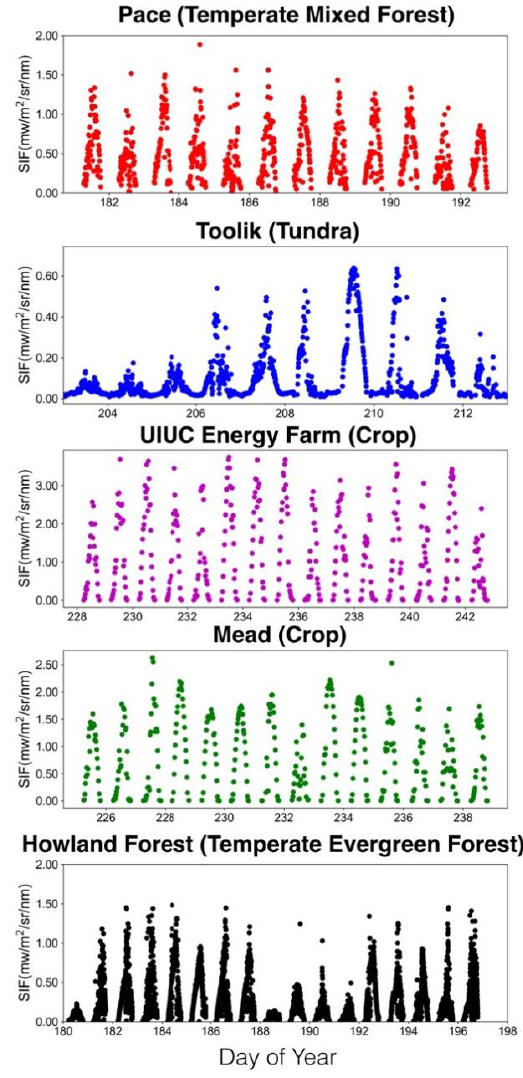
Figure 8. Examples of SIF collected during the growing season at four representative ecosystems. Table 1. SIF Network (FluoNET): site names, coordinates, and plant functional types (PFTs). * Kessler Atmospheric and Ecological Field Station ** Jurong Agricultural Ecosystem Station.